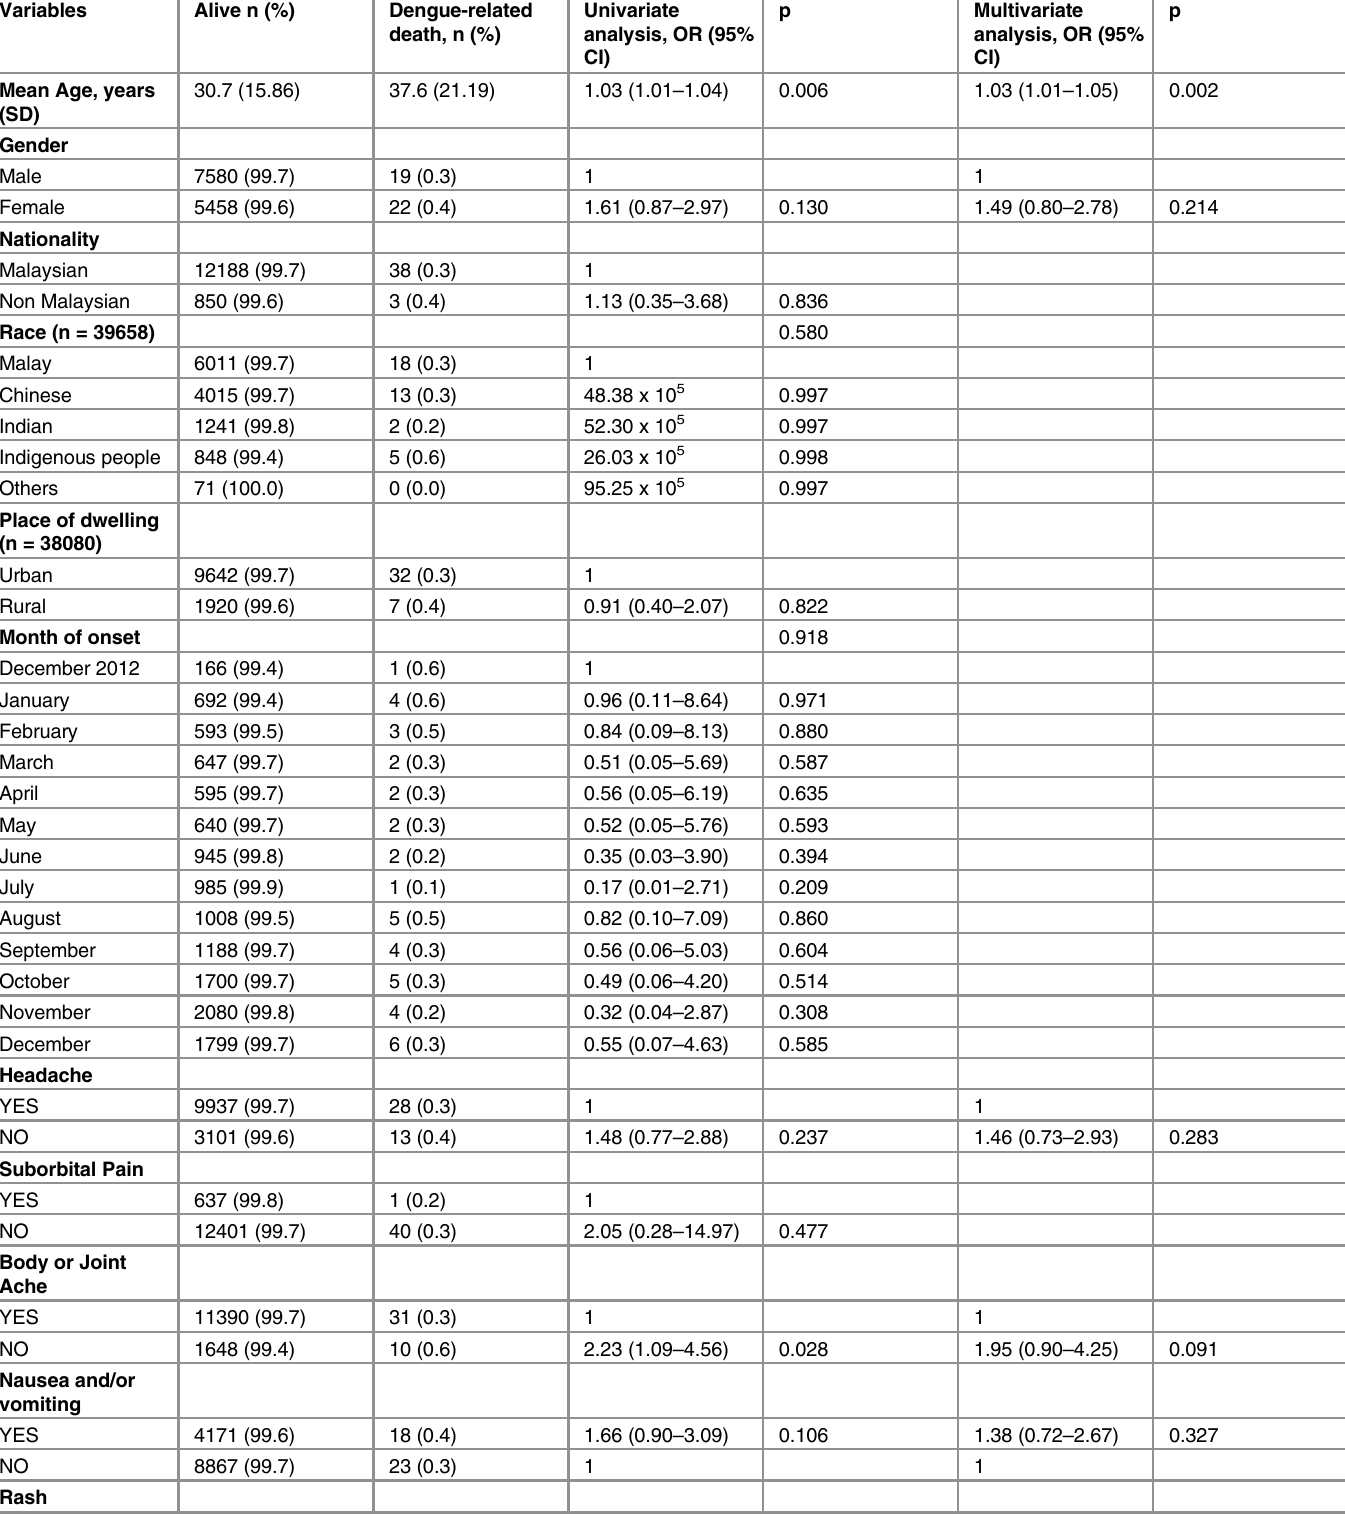
Table 3. Univariate and multivariate analysis (n = 13081) of dengue mortality in serologically-confirmed cases.